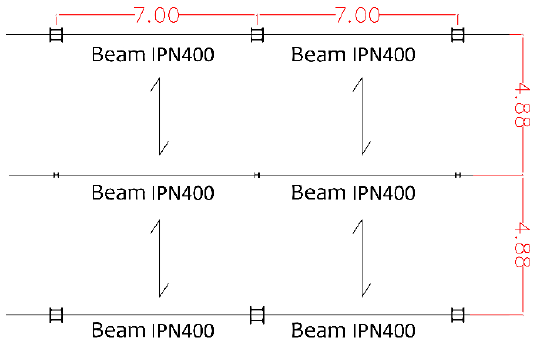
Figure 3. Dimensions of the steel ‐ framed structure.